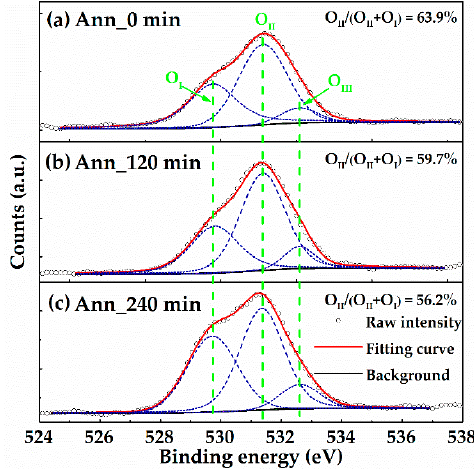
Figure 3. O 1 s XPS spectra of ( a ) 0-min; ( b ) 120-min; and ( c ) 240-min annealed a-IGMO films.